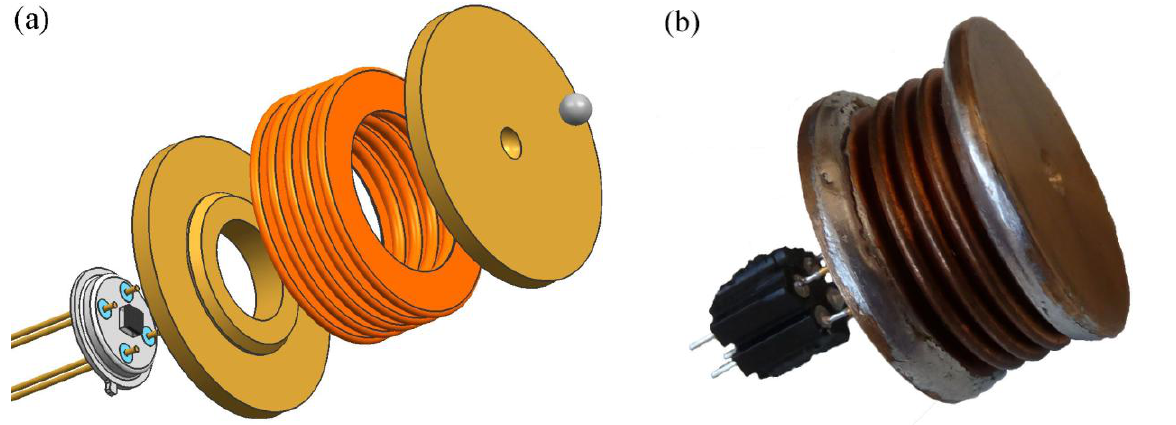
Figure 5. (a) Components of the load-cell assembly, and (b) implemented hydraulic load cell.